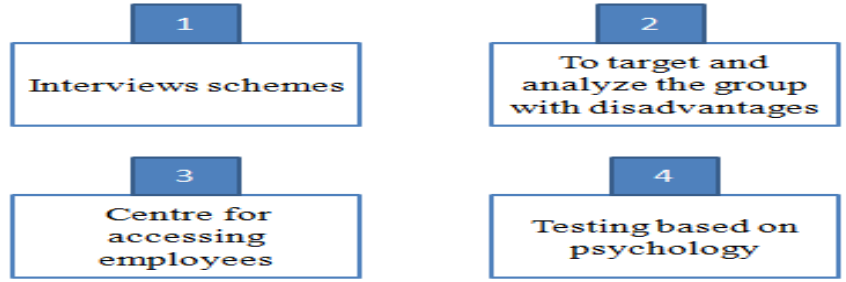
Figure 3. Brewster Figure 3. Brewster Approaches.